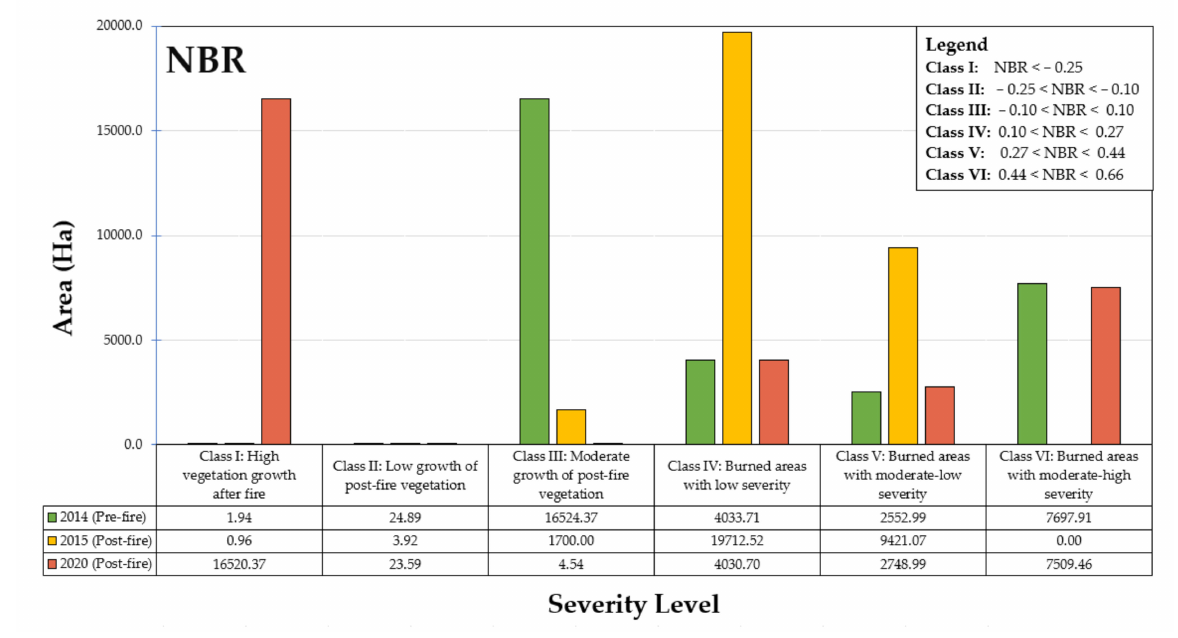
Figure 9. Severity levels represented using the NBR index with Landsat-8.